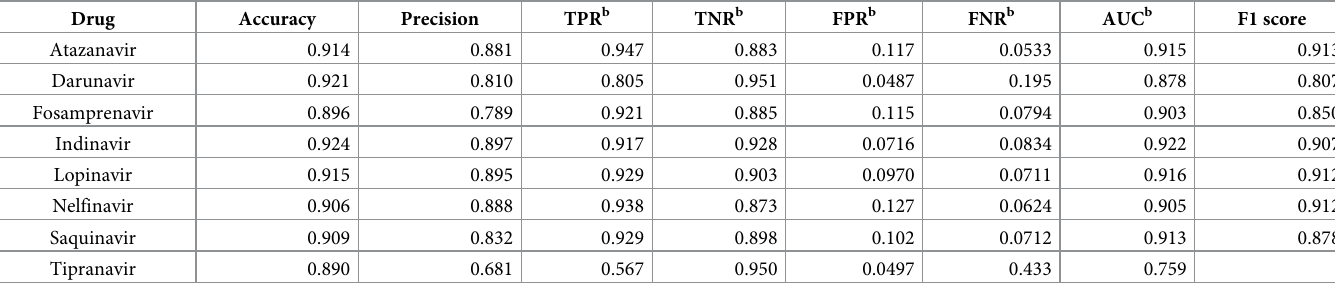
Table 3. Goodness of classification by the LGBM model a